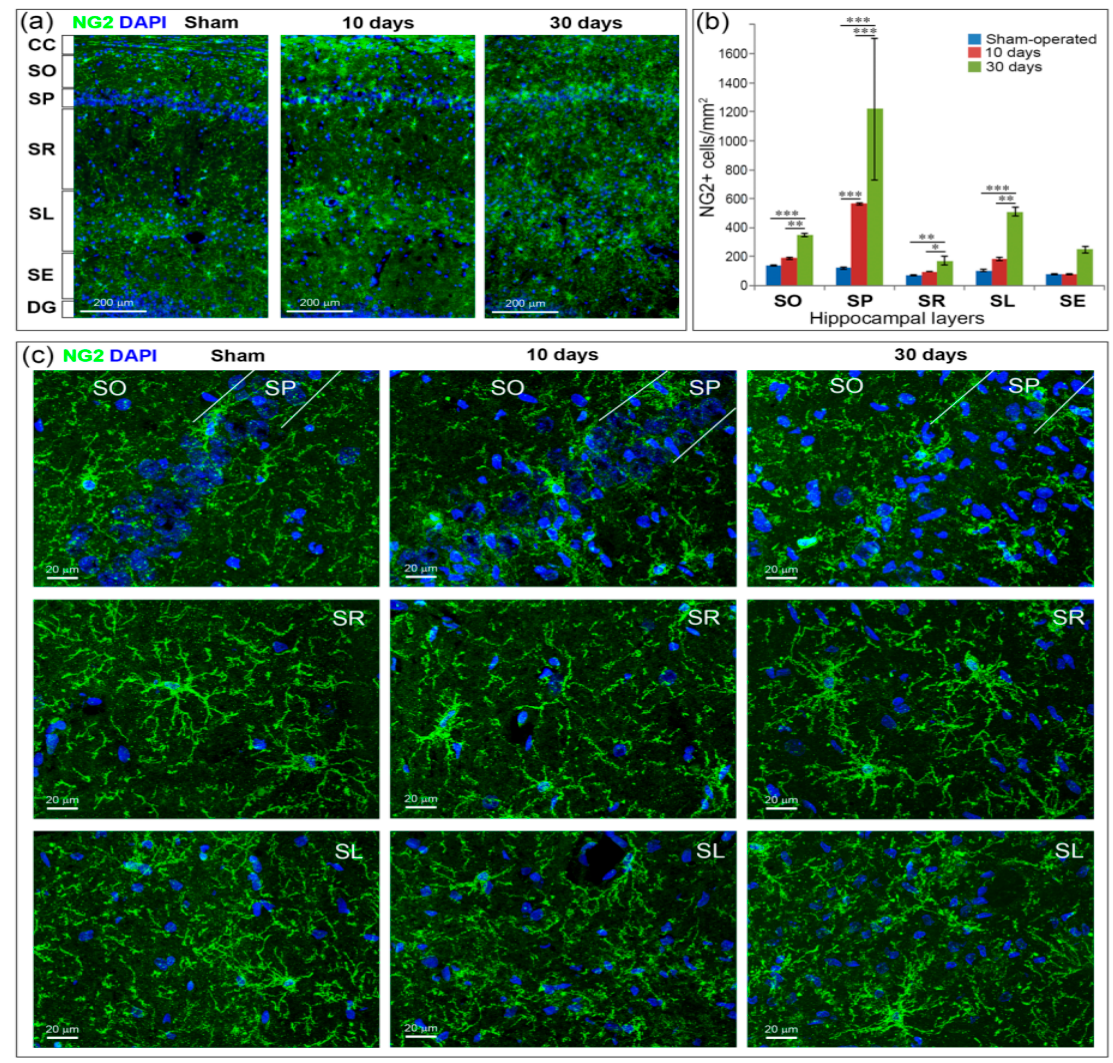
Figure 6. Oligodendrocyte precursors (OPCs) (NG2-positive cells) in the hippocampus 10 and 30 days after GCI. ( a ) Example microphotographs of the hippocampus at the CA1 field level in sham-operated controls and animals 10 and 30 days after GCI. CC—corpus callosum, SO, SP, SR, SL, SE—hippocampal layers, DG—dentate gyrus, 20 × objective; ( b ) comparison of NG2-positive cells content between the groups. Significant differences between the groups, according to ANOVA after LSD correction for multiple comparisons: *** — p < 0.001; ** — p < 0.01; * — p < 0.05; ( c ) MIP images of magnified fragments of the SO, SP, SR and SL hippocampal layers at the CA1 field. 40× oil immersion objective.